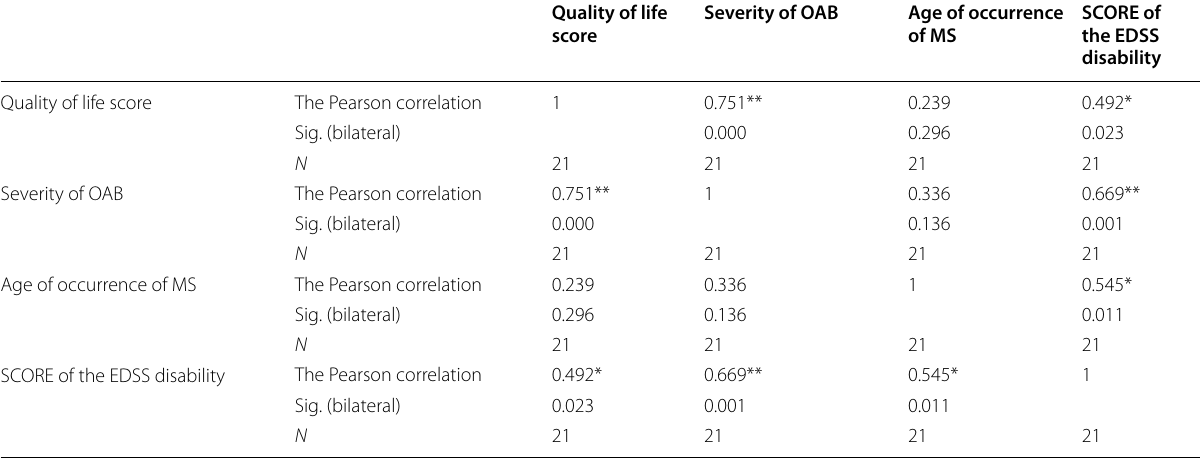
*Correlation is significant at the 0.05 level (2-tailed) **Correlation is significant at the 0.01 level